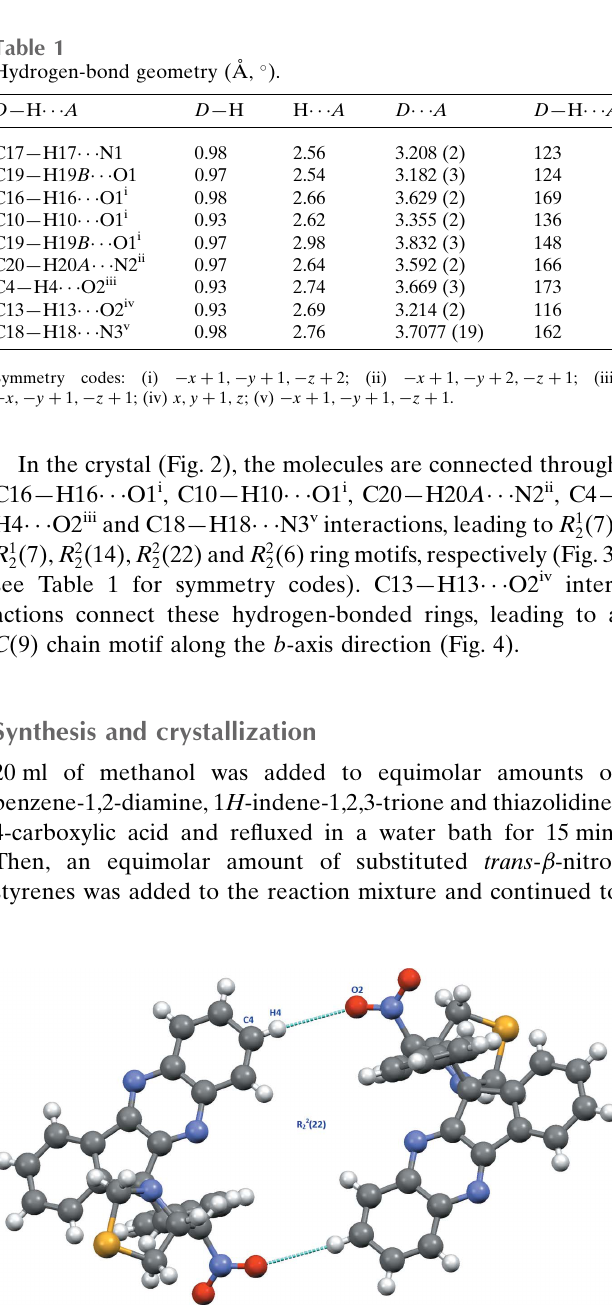
Figure 3 Centrosymmetric R 2 (22) ring motif formed through C—H (cid:3)(cid:3)(cid:3) O inter- 2 actions. Hydrogen bonds are shown as dashed lines.